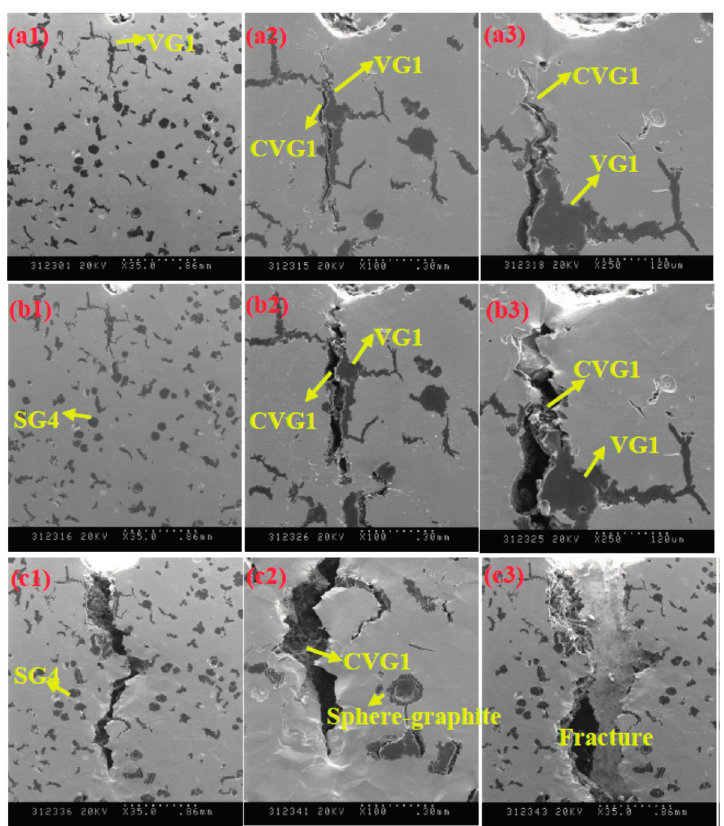
Figure 8. The crack process of vermicular graphite of heavy section ductile iron. ( a1 ), ( a2 ) and ( a3 ): the stretch of specimen is 2.1 mm; ( b1 ), ( b2 ) and ( b3 ): the stretch of specimen is 2.25 mm; ( c1 ), ( c2 ) and ( c3 ): the stretch of specimen is 2.45